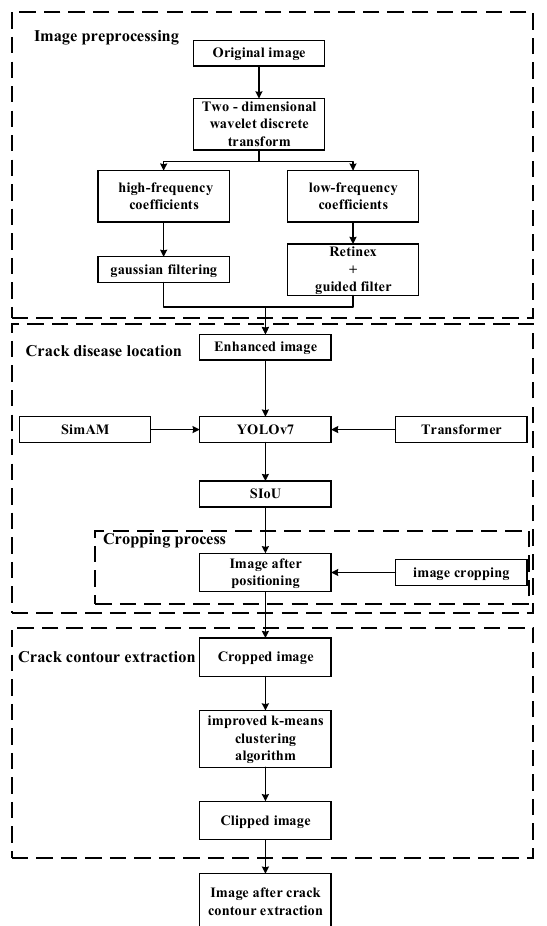
Figure 2. The flowchart of the proposed method.